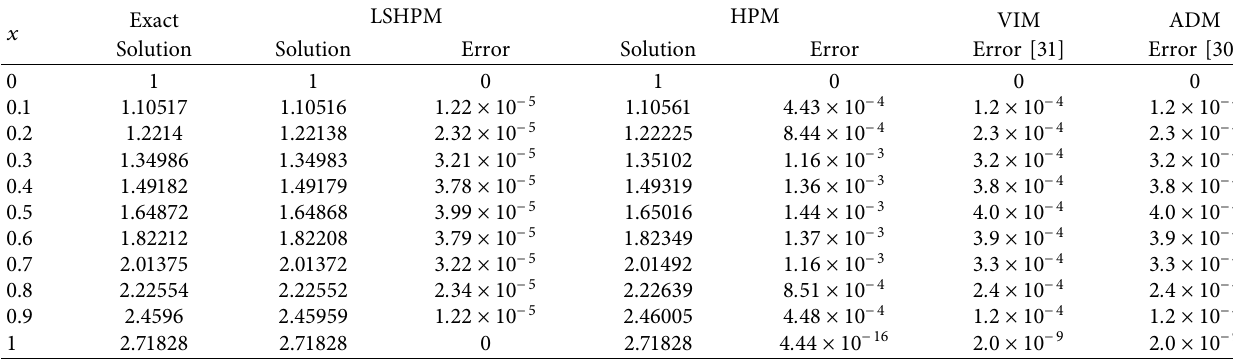
Table 10: Comparison of zeroth-order absolute error of LSHPM with second-order HPM, VIM, and ADM in Problem 10.